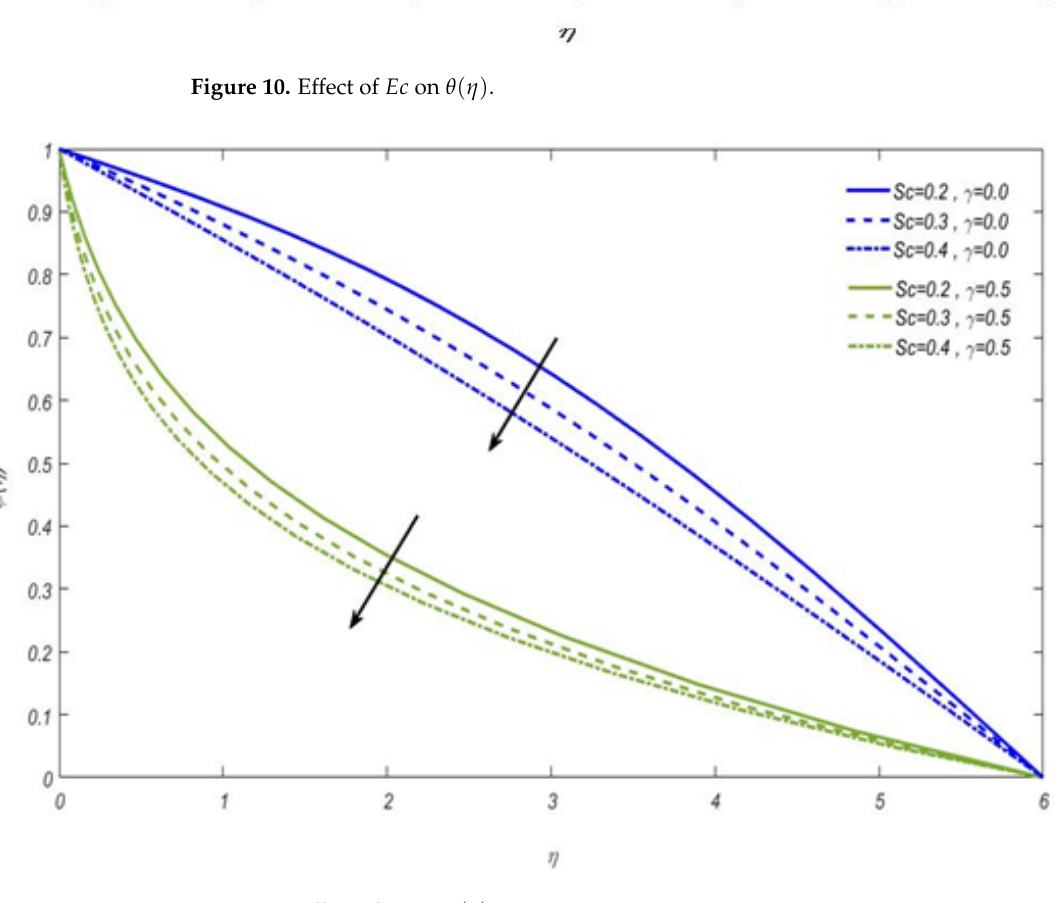
Figure 11. Effect of Sc on φ ( η )